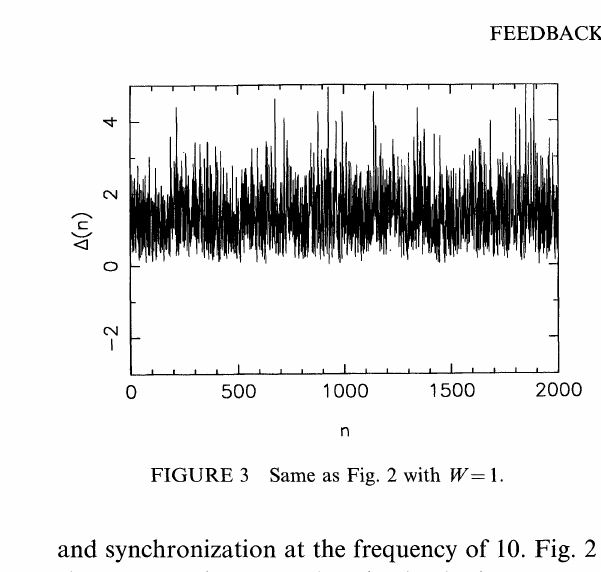
FIGURE 3 Same as Fig. 2 with W=